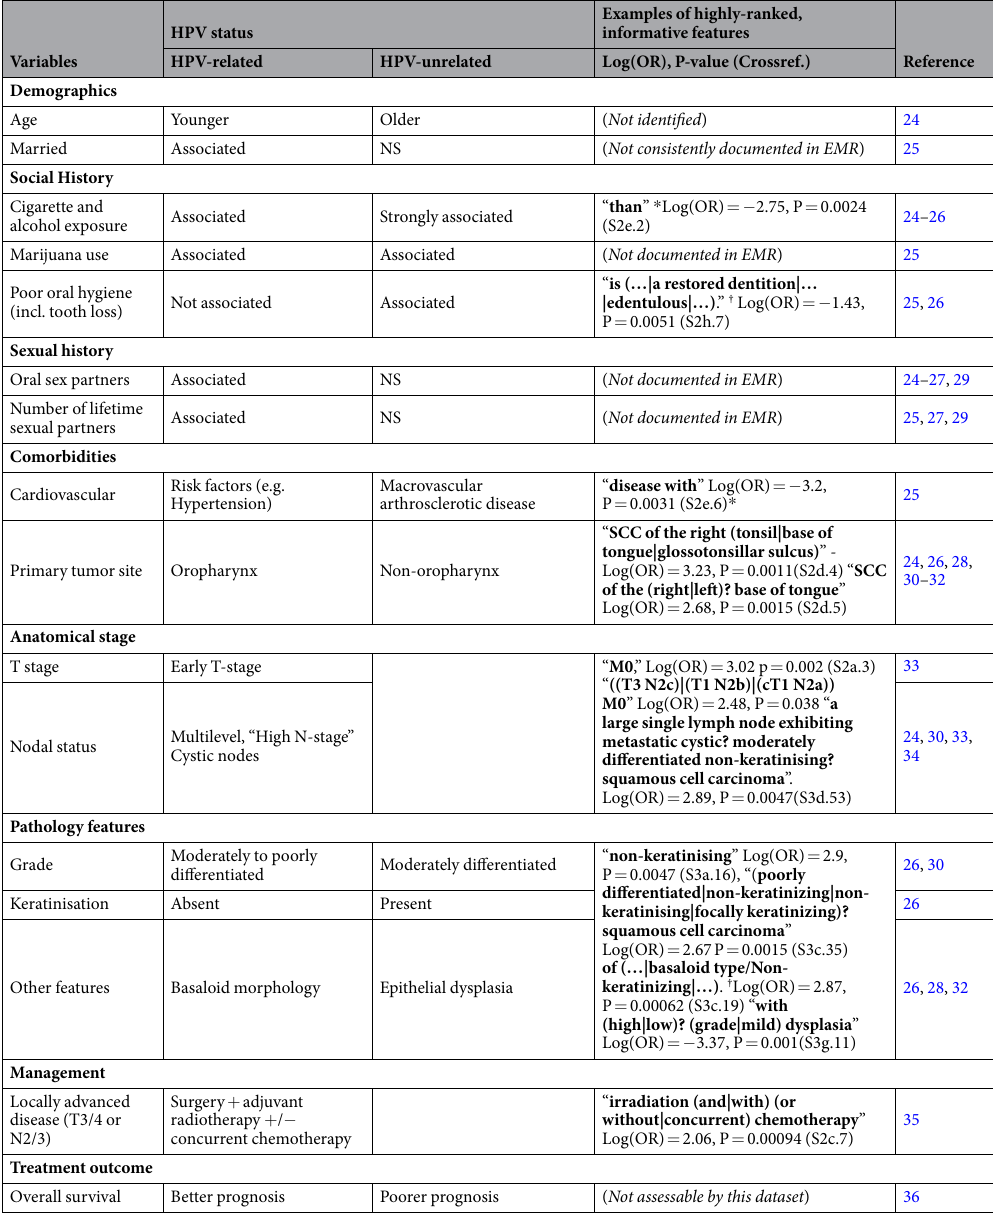
Table 3. Literature-based comparison of features associated with HNSCC by HPV status. Abbreviations: NS: Not significant. Log(OR): Log odds ratio; Note: * Refers to part of “ consumed ( greater|less ) than ”,